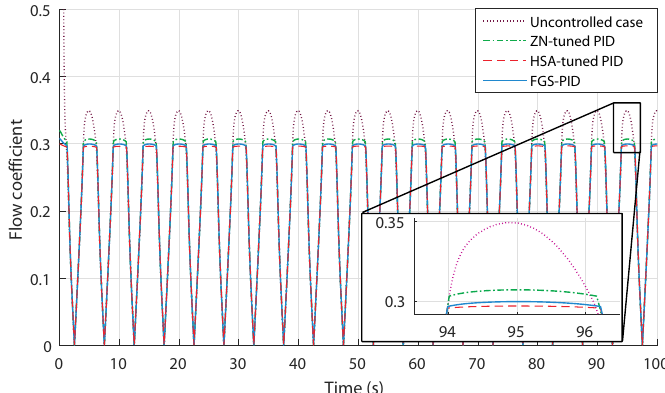
Figure 17. Flow coefficients with different control methodologies in regular waves. ZN,